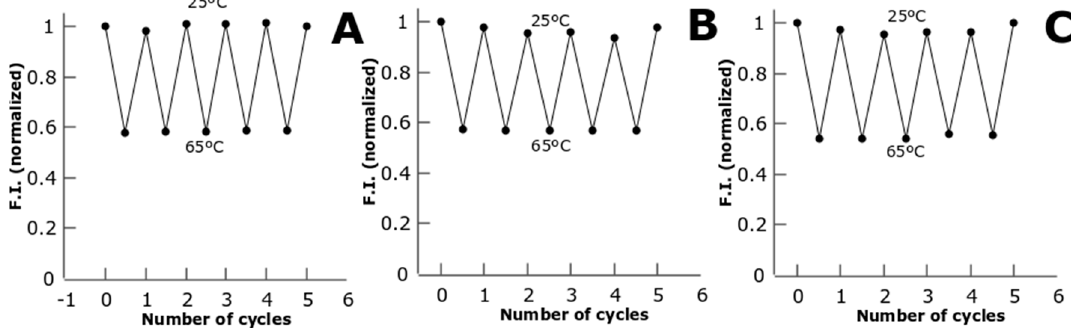
Figure 4. Normalized fluorescence intensity vs. the number of temperature cycles between 25 °C and 65 °C for C3_cys-CuNCs ( A ), C3_cys-AgNCs ( B ), and C3_cys-AuNCs ( C ).